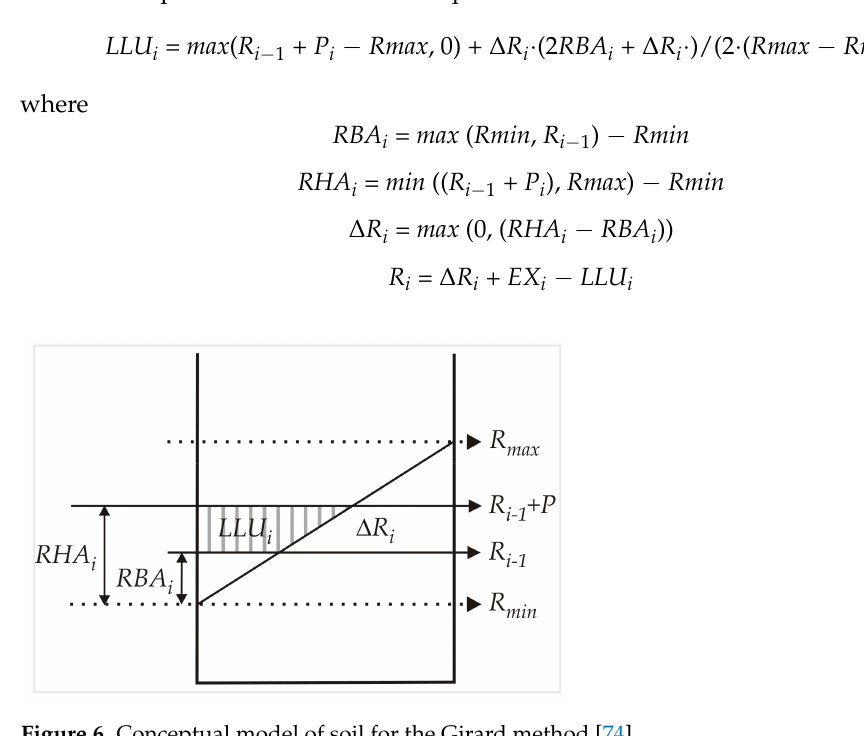
Figure 6. Conceptual model of soil for the Girard method